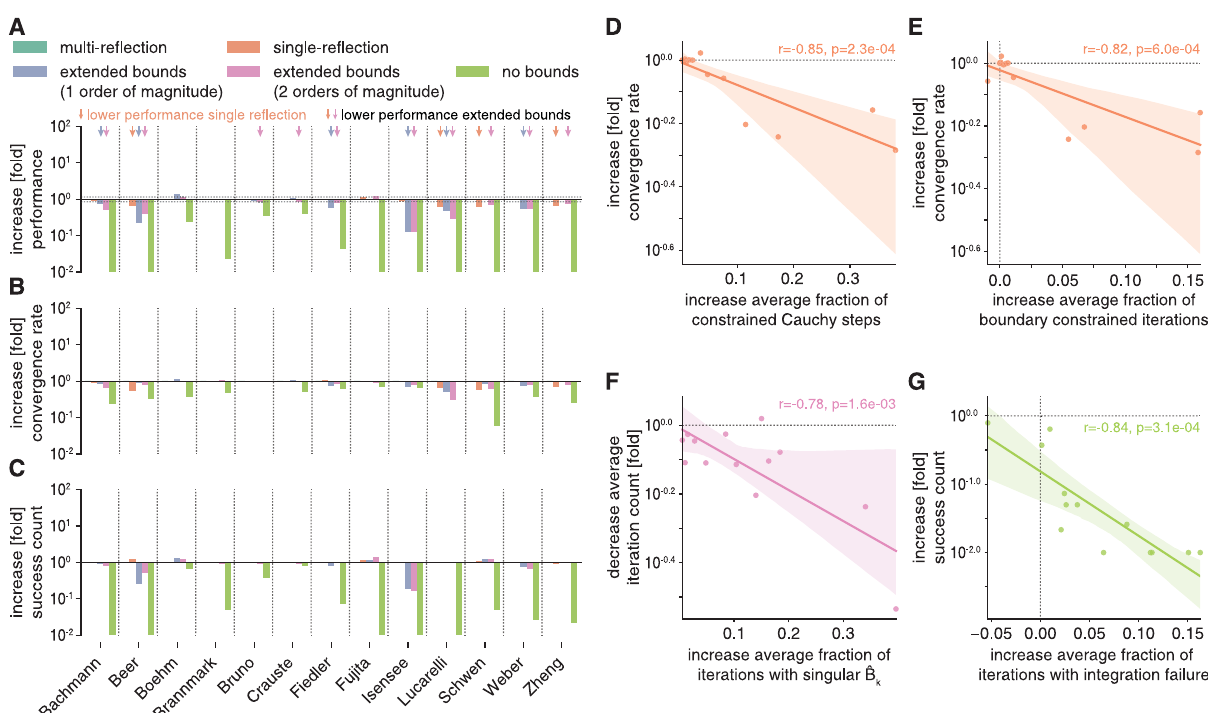
Fig 3. Evaluation of stepback strategies. Colors indicate optimizer setting and are the same in all panels. All increases/decreases are relative to multi- reflection fides 2D/GN with normal bounds. A : Performance comparison ( ϕ ). B : Increase in convergence count γ . C : Increase in convergence rate ν . D : Association between increase in average fraction of constrained Cauchy steps with respect to total number of boundary constrained iterations and increase in ν for the single-reflection method. E : Association between increase in average fraction of boundary constrained iterations and increase in ν for the single-reflection method. F : Association between increase in average fraction of iterations with a numerically singular transformed Hessian ^ B and decrease in γ for the multi-reflection method for fides 2D/GN with bounds extended by two orders of magnitude. G : Association between increase in average fraction of iterations with integration failures and increase in γ for multi-reflection fides 2D/GN without